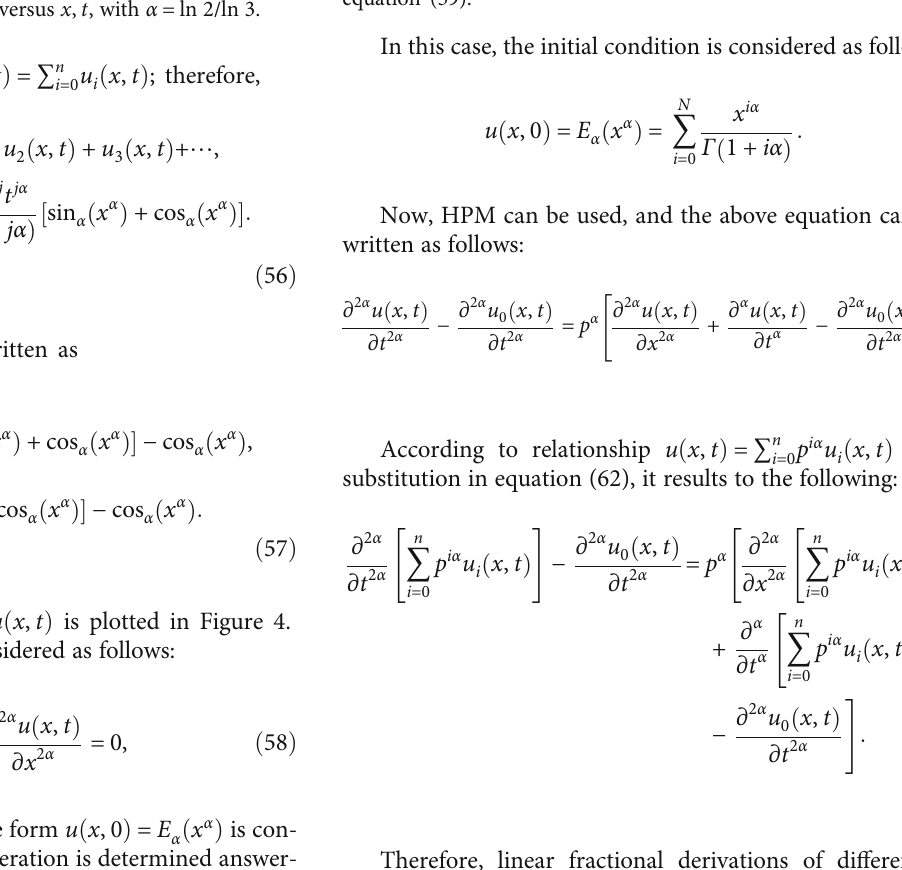
Figure 5: Variation of u ð x , t Þ versus x , t with α = ln 2/ln 3 , equation